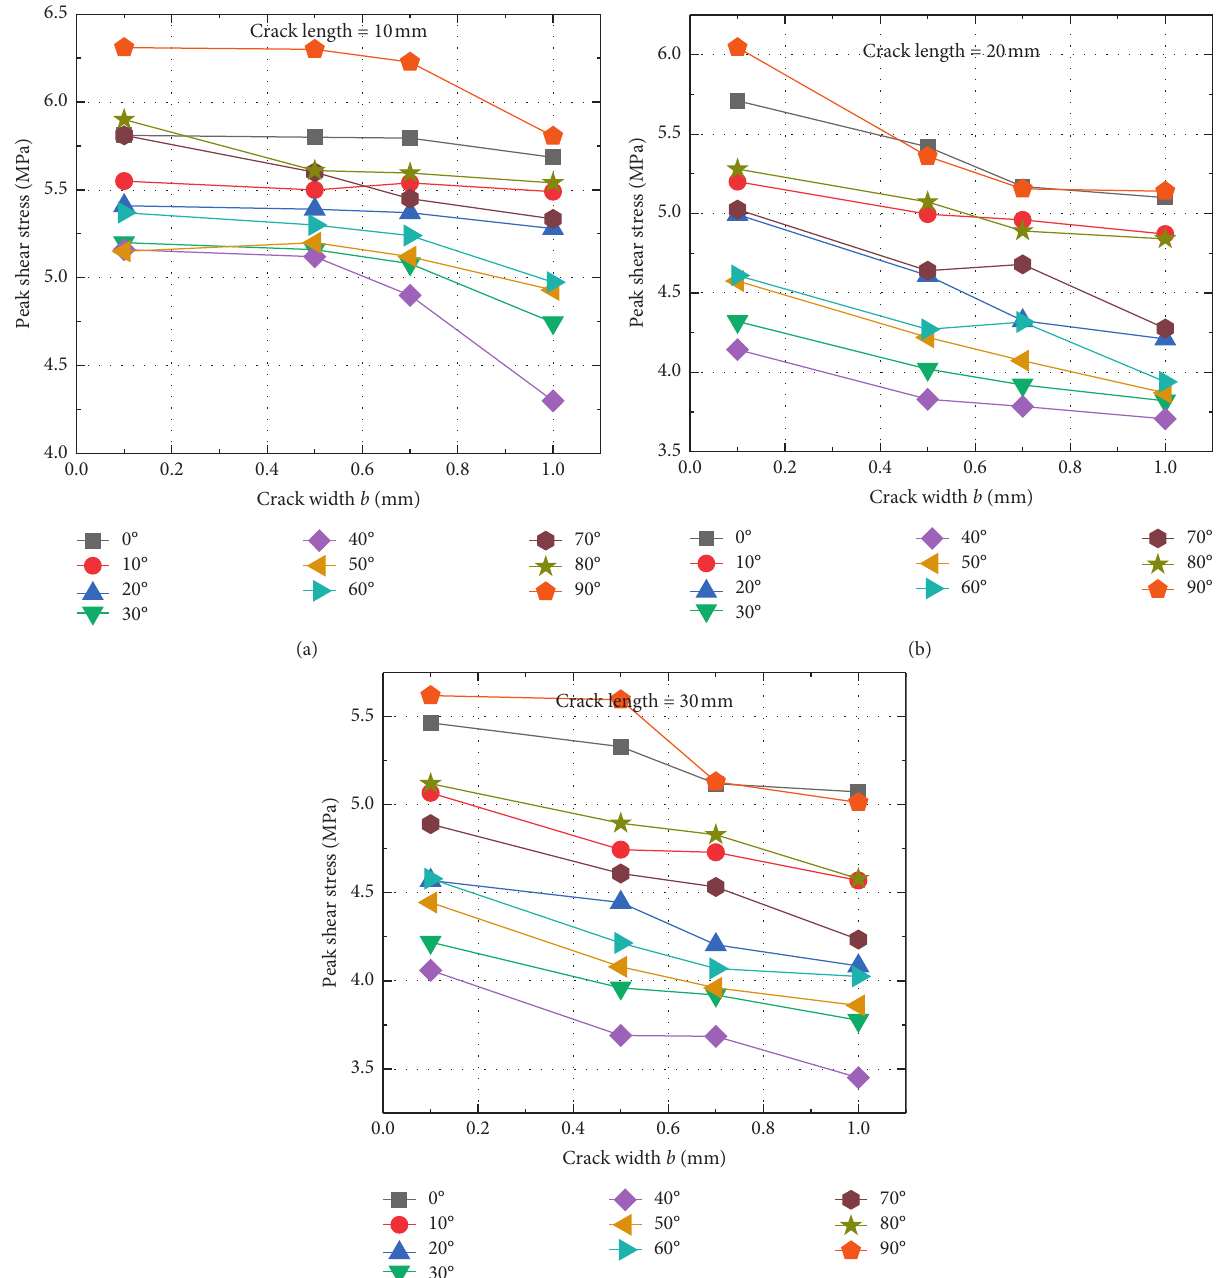
Figure 5: Relation curve between prefabricated fissures with different widths and peak shear strength of